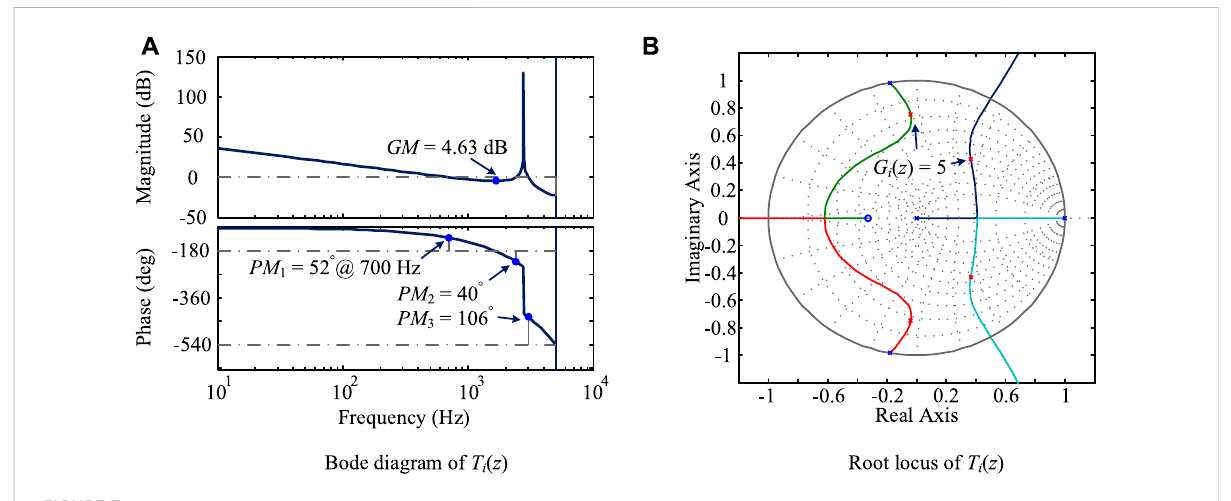
FIGURE 7 Bode diagram and root locus of T i ( z ) with system parameters listed in Table 1. (A) Bode diagram T i (z) . (B) Root locus of T i (z)